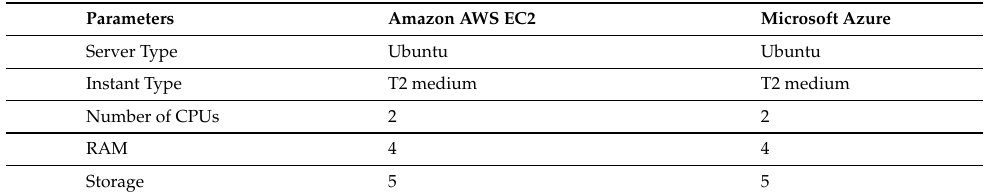
Table 1. Servers’ configuration